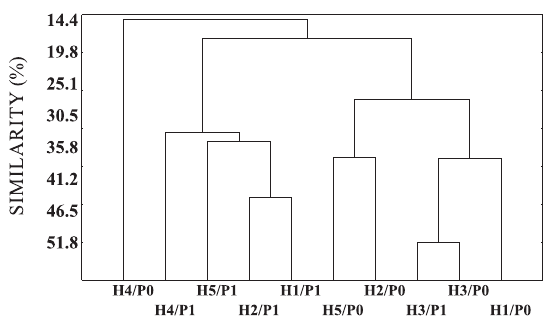
Figure 5. Cluster analysis based on the presence and absence of substrates (72 h of incubation) by the microbial extract from the rhizosphere of maize genotypes grown at two P levels (P0 = low and P1 = high). Utilizou-se a UPGMA cluster analysis and Euclidian